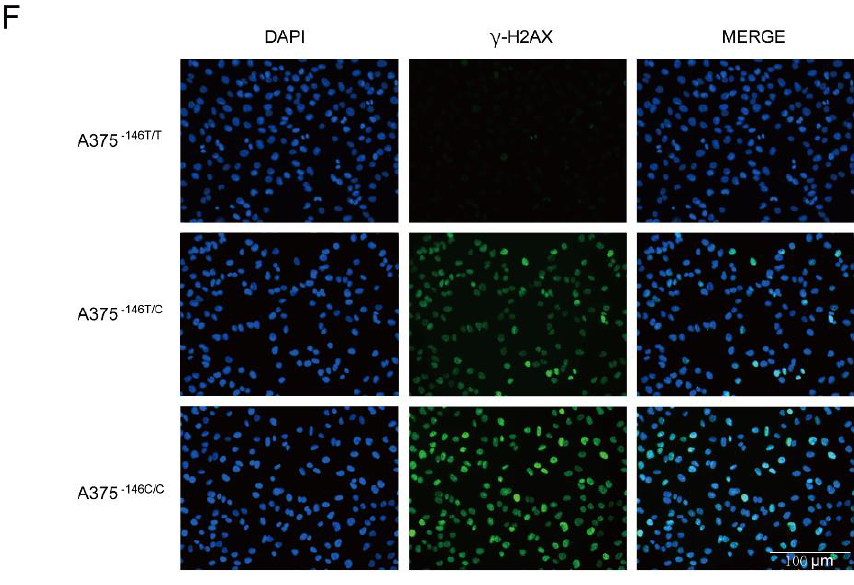
Figure 2. TERT -146 T>C reduces telomere length, migration and invasion of A375 -146T/C and A375 - 146C/C . ( A ) Schematic diagram of somatic cell carcinogenesis and revertant mutation; ( B ) telomere length measurements. DNA extraction from cells for Q-PCR. Mean change in telomere length (T/S) of A375 -146T/C and A375 -146C/C . Reference cell line: HepG2; ( C ) cell migration assay. Migration and invasion tests measured by Transwell; ( D ) cell invasion assay; ( C , D ) the vertical coordinate indicates the percentage of migrated or invaded cells. Student’s t -test. * p < 0.05, *** p < 0.001, **** p < 0.0001; ( E ) changes in the morphology of A375 -146T/C and A375 -146C/C compared to A375 -146T/T (triangles: